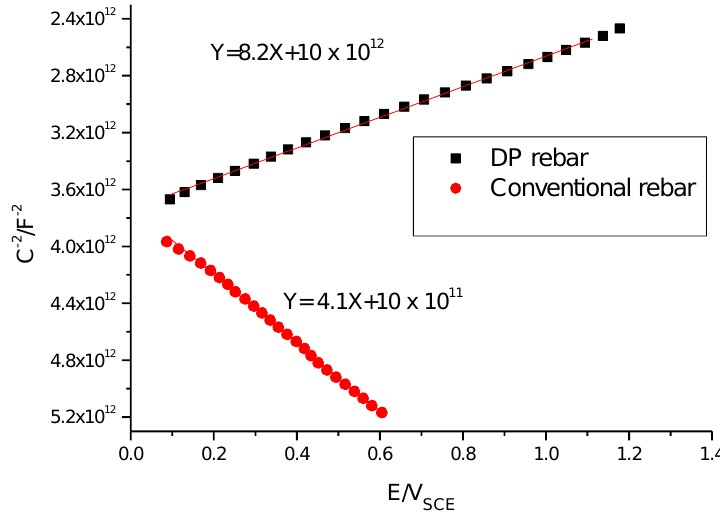
Figure 10. Mott–Schottky plot of DP rebar and conventional Figure 10. Mott – Schottky plot of DP rebar and conventional rebar.